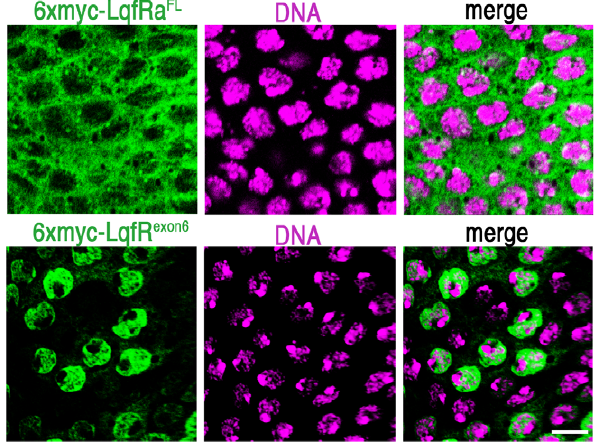
Figure 3. Subcellular localization of Myc-tagged LqfR proteins. Confocal microscope images of third instar larval eye disc tissue from two different discs (each row is a single disc) are shown. The portion of the eye disc shown is the peripodial epithelium, a layer of cells that lies atop the cell layer that forms the retina. The peripodial cells are large and flat the nuclei and cytoplasm are distinguished more easily than in the retinal cells. The discs were immunostained with antibodies to the Myc epitope (green) and the DNA stain TOPRO3 (purple). The Myc- tagged proteins indicated were expressed by UAS transgenes using an Actin5C-gal4 driver. scale bar: , 10 m